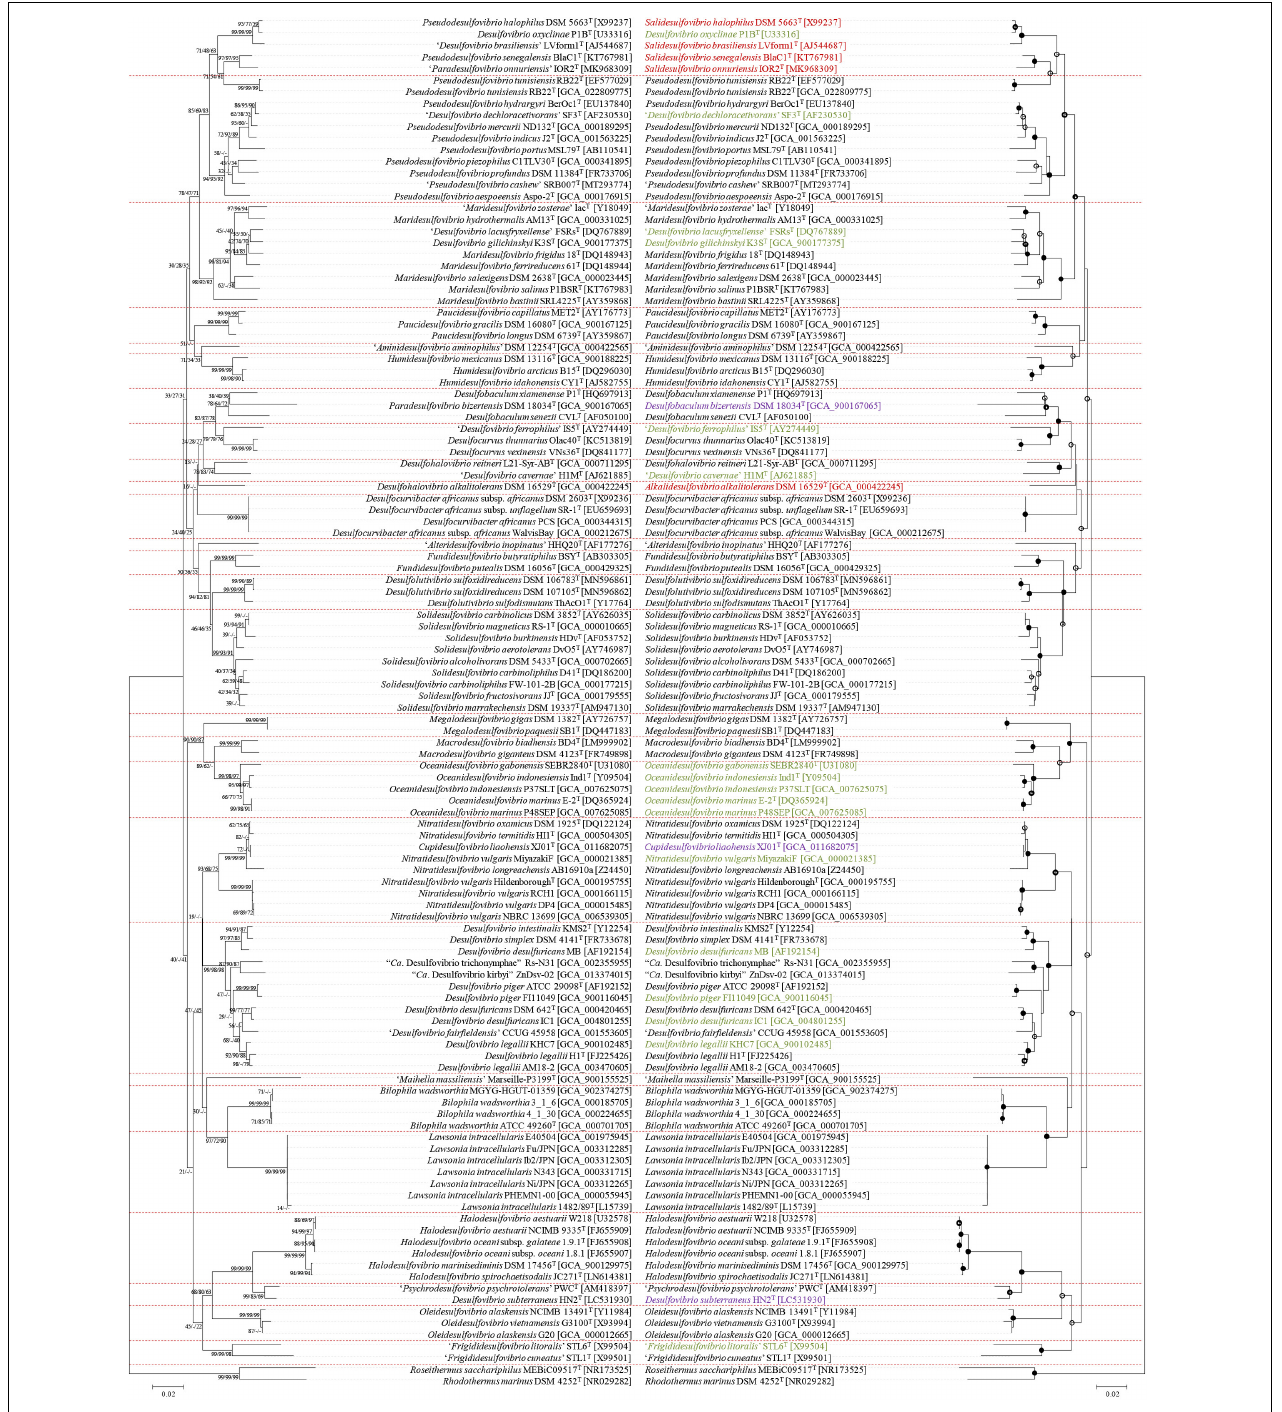
FIGURE 4 | Reclassification of the Desulfovibrionaceae by 16S rRNA gene sequence similarity inferred by genomic tree. This figure includes mirror image. Left sided tree is before reclassifications, Right sided tree is after reclassifications. Purple colored label, rearrangement through this study; Red colored label, proposed as a new genus; Green colored label, which has the potential to be newly classified, but requires further researches because it cannot be achived at this moment: lack of detailed phenotypic characterization or lack of available genome sequence or lack of available culture in two public culture collections. The tree is based on the Jukes & Cantor distances model and the neighbor-joining method with 1,000 bootstraps. Nodes with branch support > = 70% recovered by the three algorithms (the neighbor joining, the maximum-likelihood, and the maximum-parsimony algorithm) were indicated with • ; Nodes recovered by the three methods but with < 70% bootstrap values were indicated with (cid:13) ◦ ; Nodes recovered by two of the above methods were indicated with ◦ .